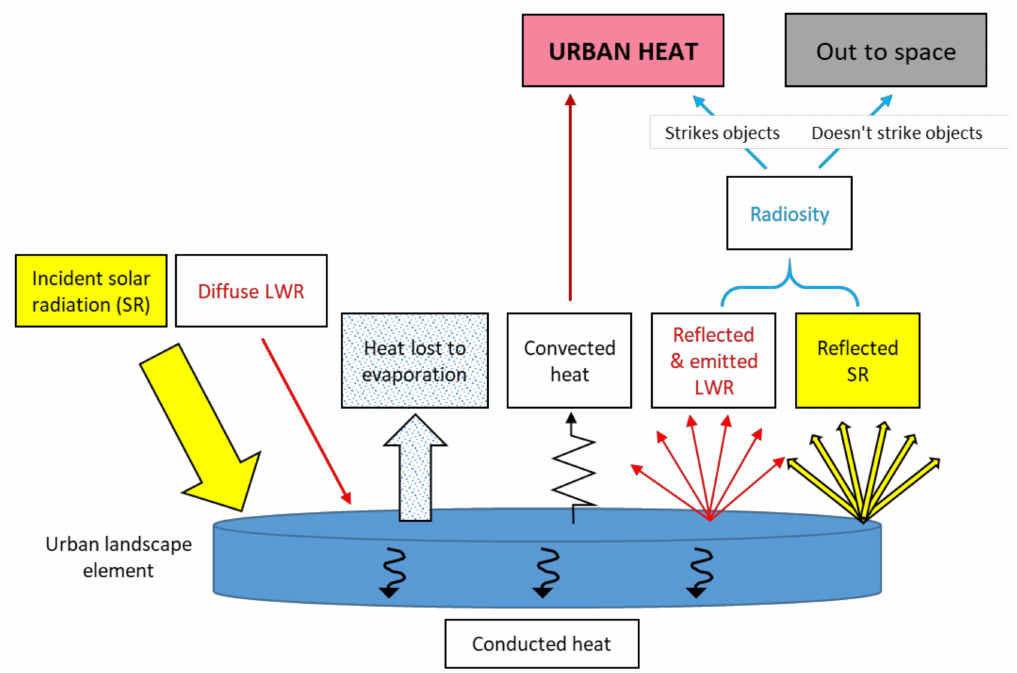
Figure 1. Energy balance of an urban landscape element. The range of longwave radiation (LWR) is defined here as 2.5 µ m–100 µ m. Solar radiation, also termed shortwave radiation (SWR), ranges from 0.3 µ m–2.5 µ